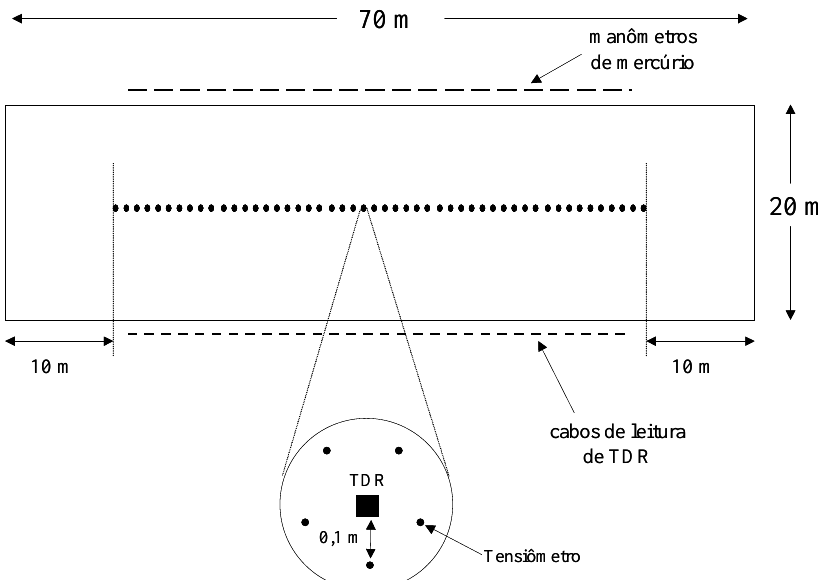
Figura 1. Parcela experimental com a localização dos 50 pontos de observação. O detalhe mostra a configuração de um ponto de observação com TDR e